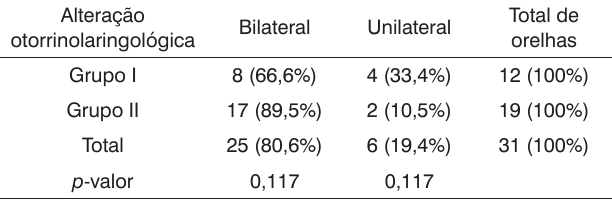
Tabela 2. Ocorrência de alterações otorrinolaringológicas bilaterais ou unilaterais nos grupos I e